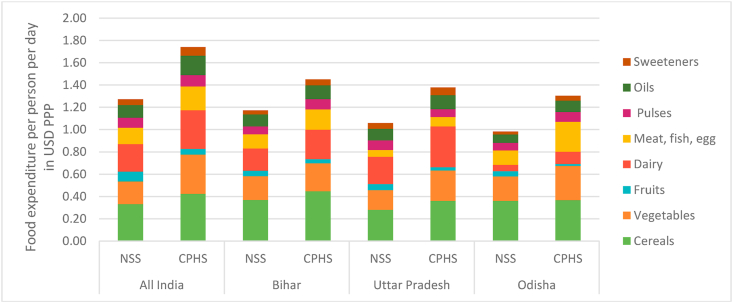
Comparison of food expenditures using NSS (2011–12) and CMIE (2018–19) data.